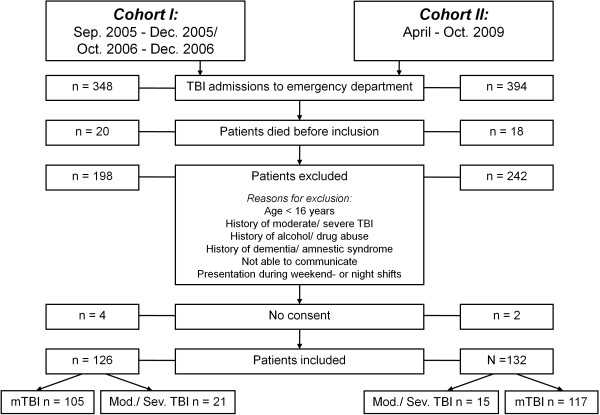
Inclusion flow diagram of the derivation cohort (Cohort I) and the validation cohort (Cohort II). Sep., September; Oct., October; Dec., December; TBI, traumatic brain injury; mTBI, mild traumatic brain injury; Mod., moderate; Sev., severe.